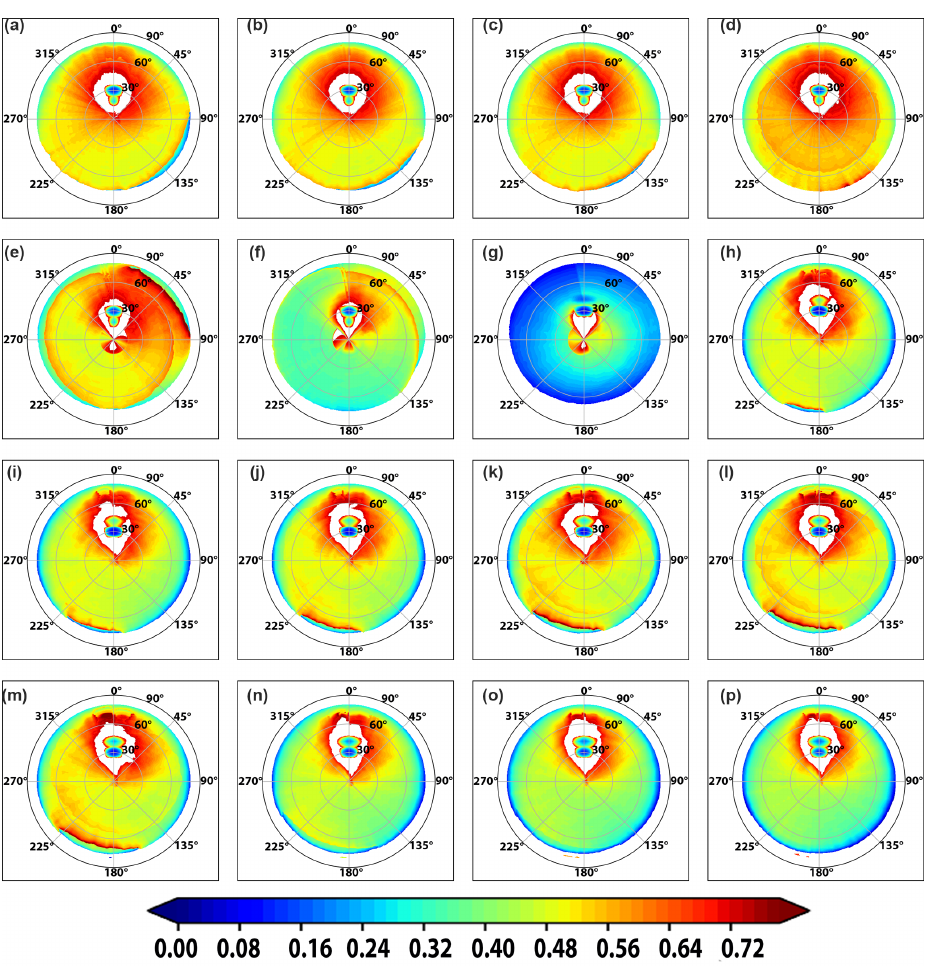
Figure 8. Retrieved aerosol optical depth ( λ = 0.500µm) above clouds and the aircraft, obtained from the CAR sky radiance measurements. Note that the actual retrievals are performed at 470 and 860nm assuming an extinction Ångström exponent of 1.77 (see also Table 2). Pixels without valid retrievals are shaded white. The spurious retrieval of AOD around the solar disk is a result of saturation in the CAR reflectance measurements, partly due to the inability of the RT model to simulate reflectance when directly looking at the